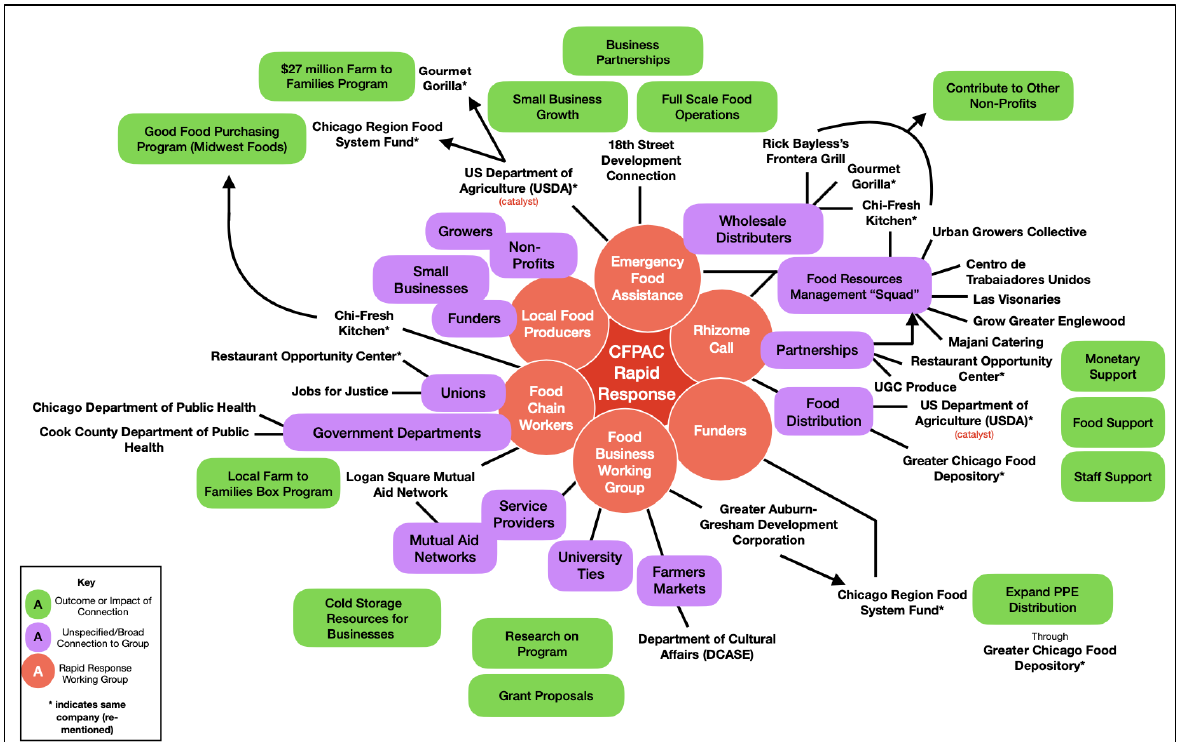
Figure 2. Network and Outcomes of CFPAC’s Rapid Response Effort, as Described by CFPAC Staff Interviewed Virtual working groups are represented in red/orange, categorical sectors in the regional food system in purple, and perceived impacts in